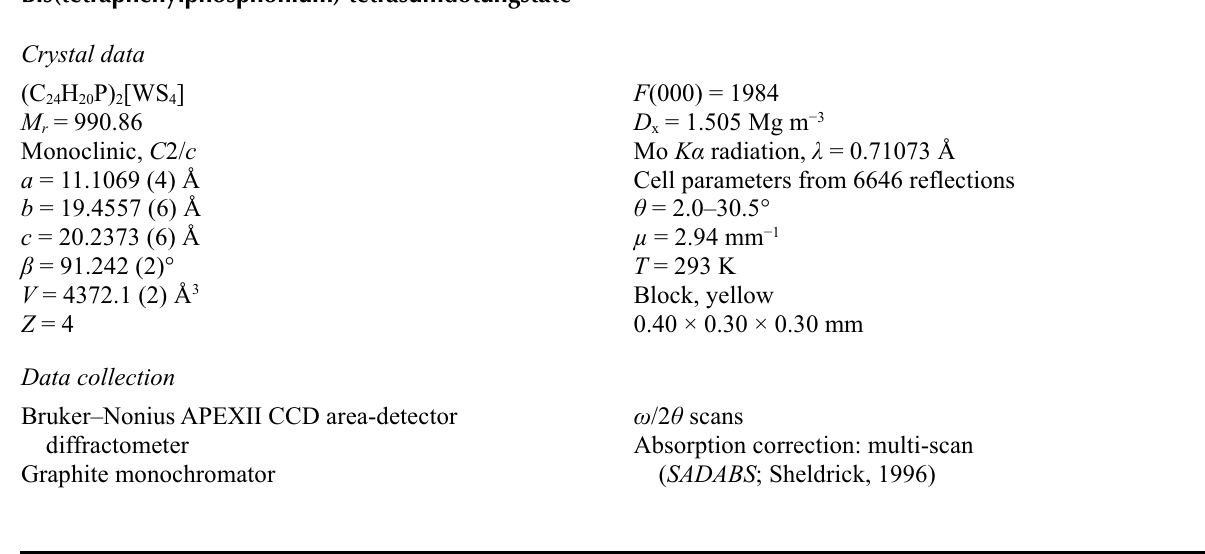
P] [WS ] structure along the [110] direction. The relatively short P···.P distances within the zigzag chains View of the [Ph 4 2 4 are shown as red lines. H atoms have been omitted for